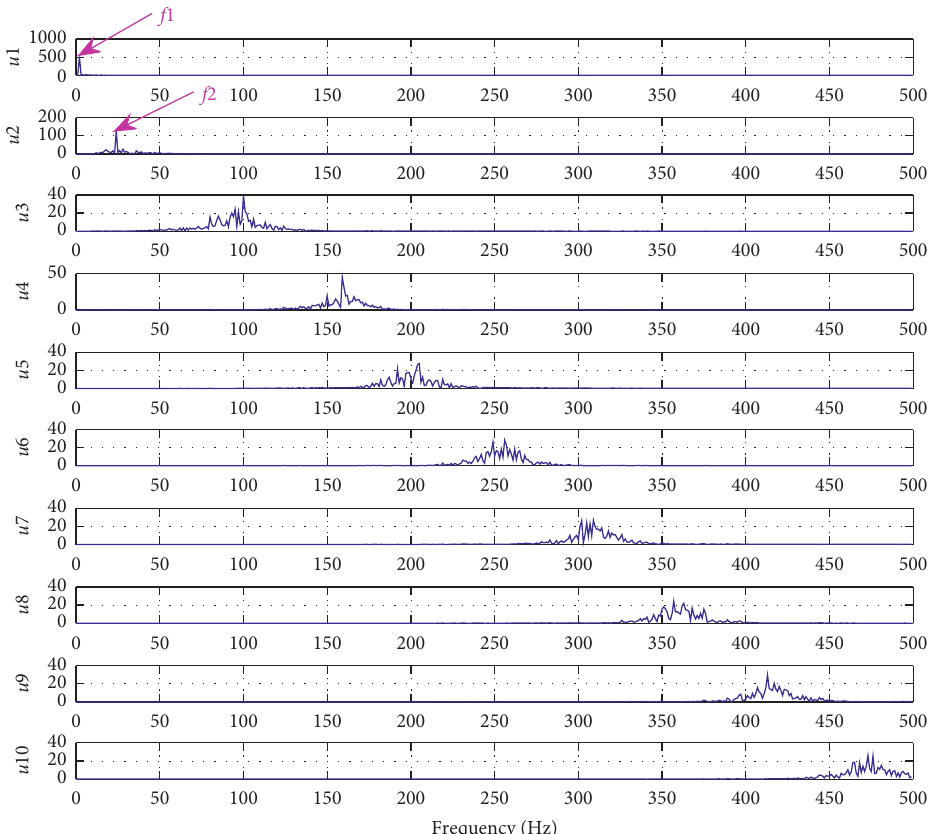
Figure 7: The spectrum of each mode decomposed by